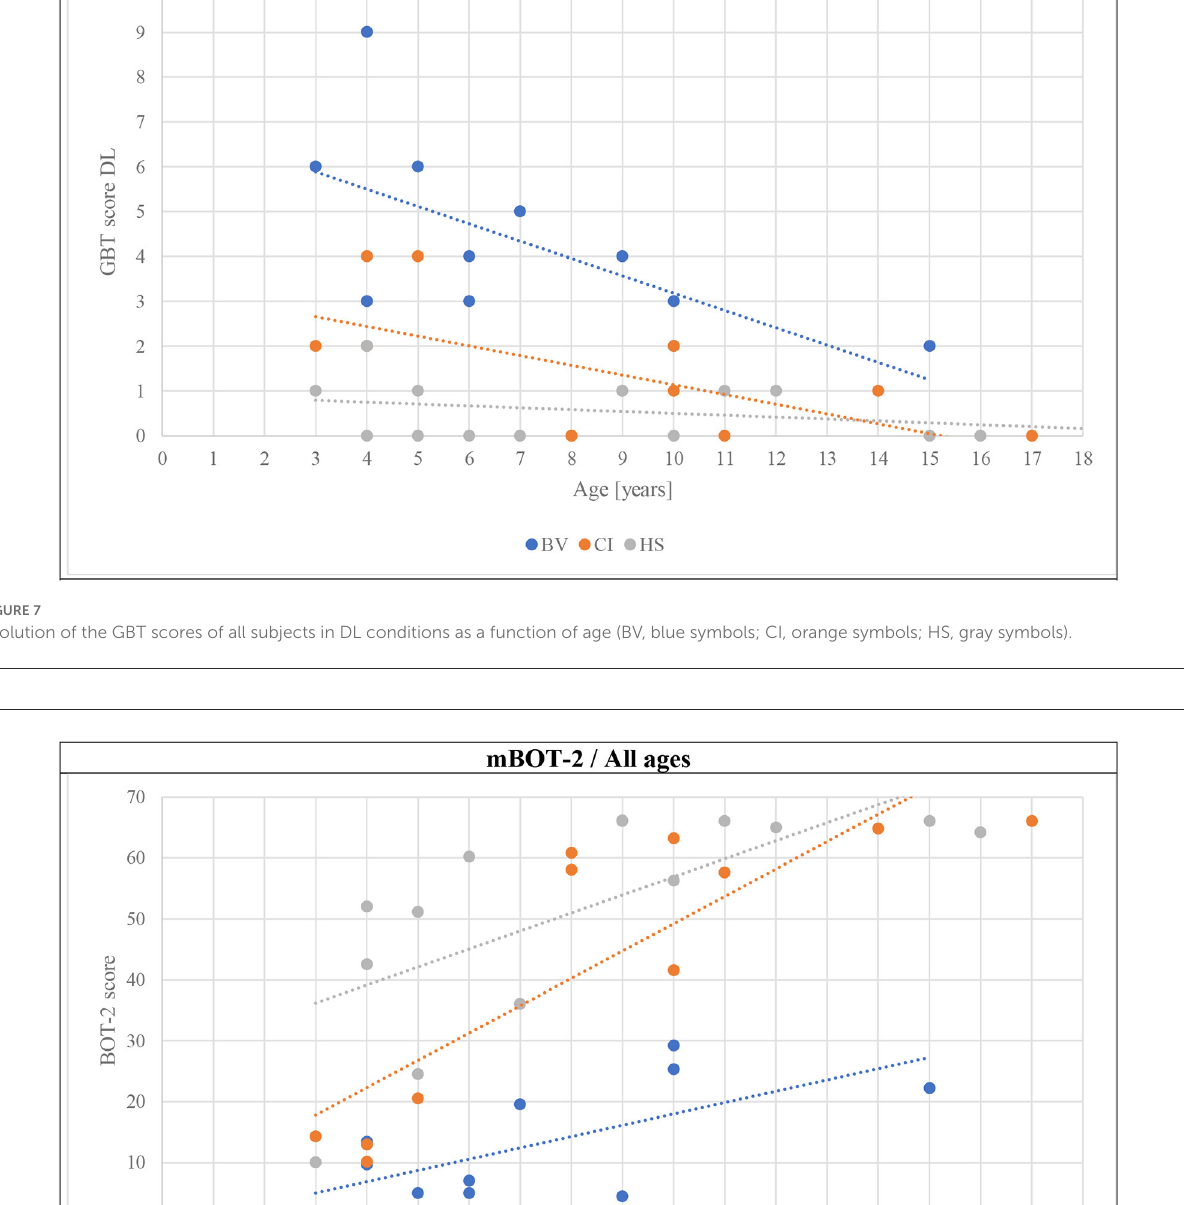
increasing age but maintain poorer scores for ≥ 10 years old than young 3–5 years old HS. The possibility of observing clear and consistent improvements with age demonstrates the potential of the GBT to monitor the evolution of children’s balance abilities with